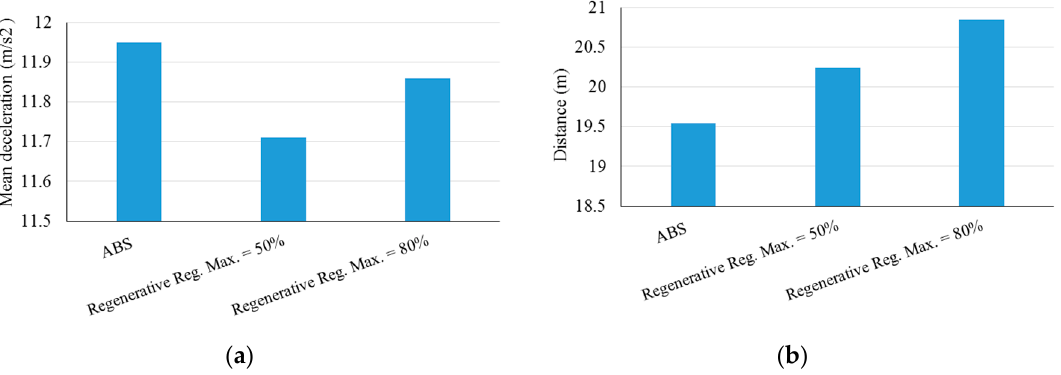
Figure 9. results of the study by Aguilar [49] in terms of ( a ) mean deceleration and ( b ) distance.